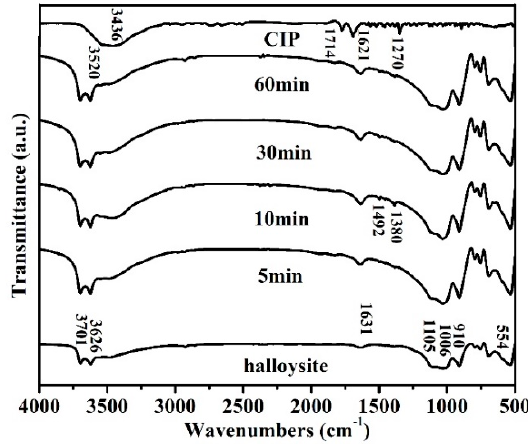
Figure 4 . Fourier transform infrared spectroscopy (FT-IR) spectra of HNTs before and after CIP adsorption. Morphology and size of HNTs have an important influence on their property [48,49]. Scanning